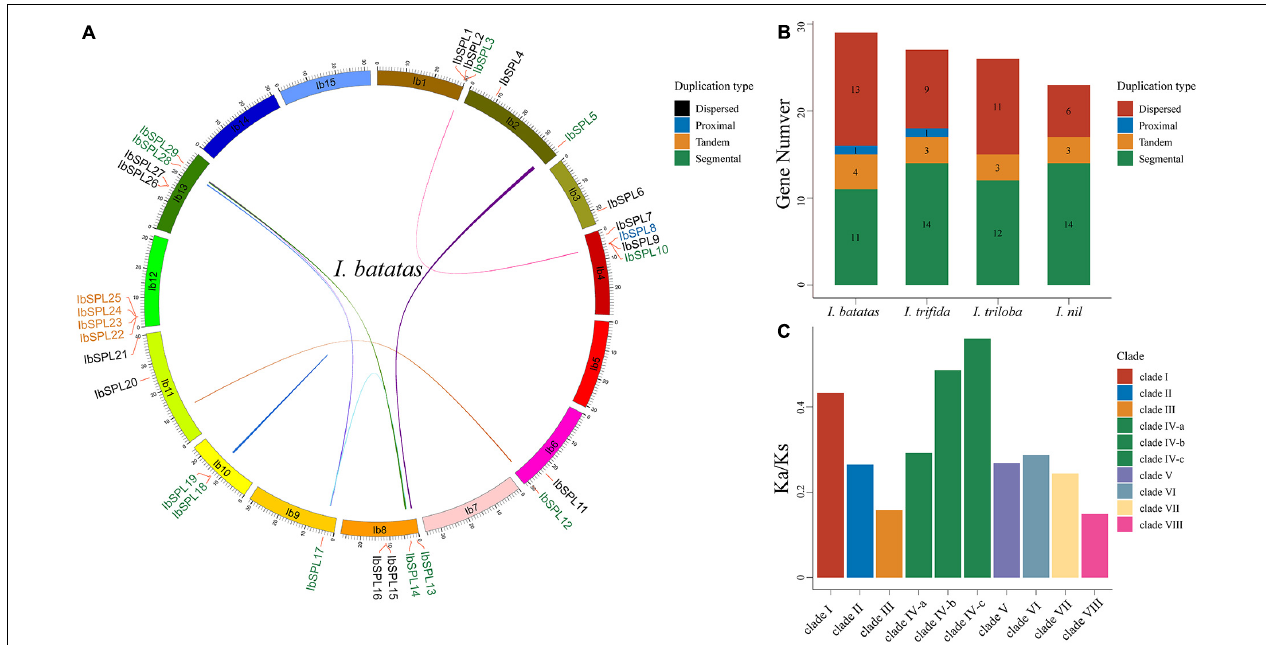
FIGURE 3 | Syntenic relationships and selective pressure of Ipomoea SPLs. (A) The collinear relationship of SPL genes in I. batatas , wherein the colored lines indicate syntenic regions. IbSPL genes are classified into four duplicated types, each indicated by a different color. (B) The distribution of SPLs duplication modes in four Ipomoea species. (C) The mean Ka/Ks values in each